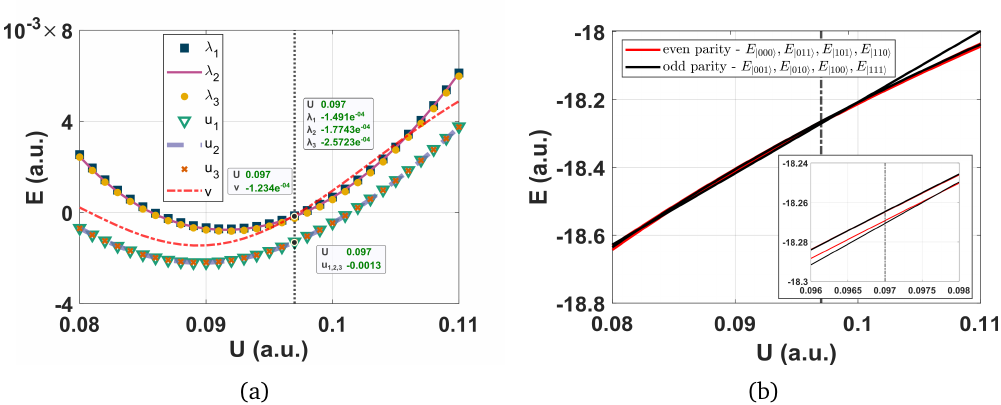
Figure 10: The SYK point parameters for three-complex-fermion model for an N = 10 = 3, n = 4, second site Kitaev chain model (first non-topological segment: n nt1 1 nt1 2 = 7, n = 8) obtained using a hybrid genetic al- non-topological segment: n nt2 1 nt2 2 gorithm search, i.e., method (ii) described in Section 6.5 are: t = 0.1, ∆ = 0.1315, µ = 0.5746, µ = 0.5743, µ = 0.5746, µ = 10, µ = 10, U = 0.097. (a) t1 t2 t3 nt1 nt2